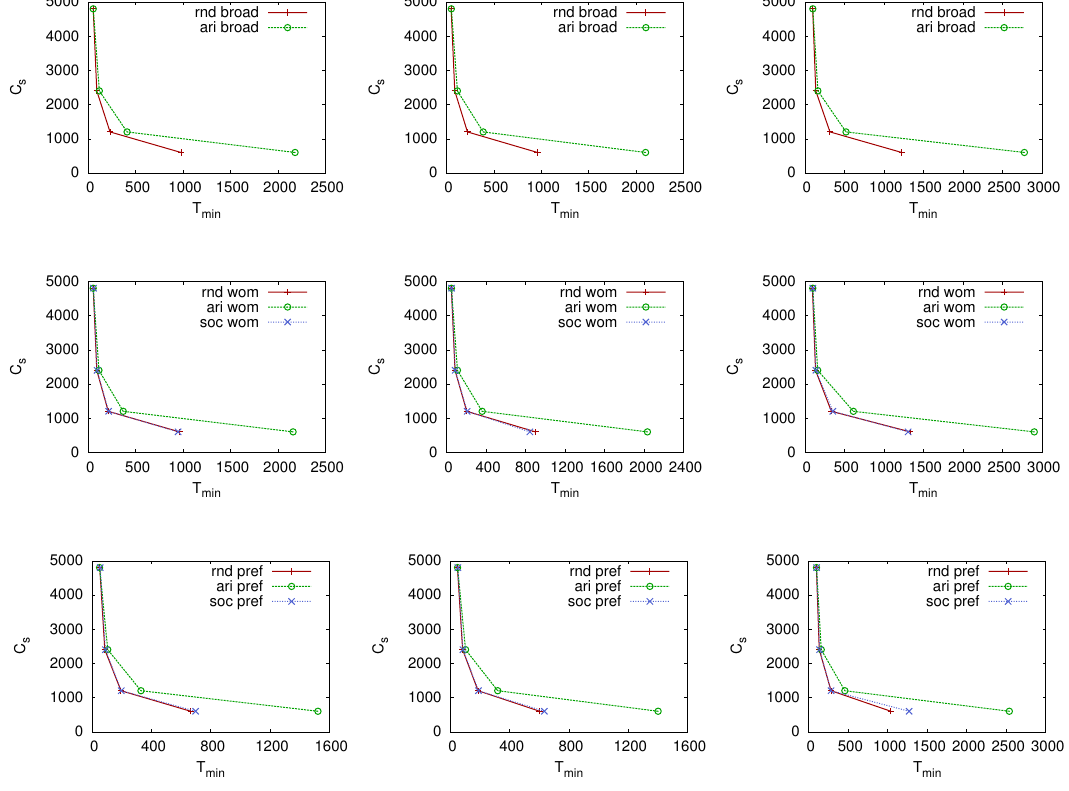
Figure 24. Scatter plots between cost C s and T min in VirtualTourist. T min represent the minimum number of steps (in simulated time units) necessary to get the target efficiency ( E glob ). We consider three thresholds: half (leftmost column), one third (centermost column) and full (rightmost column) efficiency. Every row represents a different mermaids’ model, namely broadcast , word of mouth , and preferential